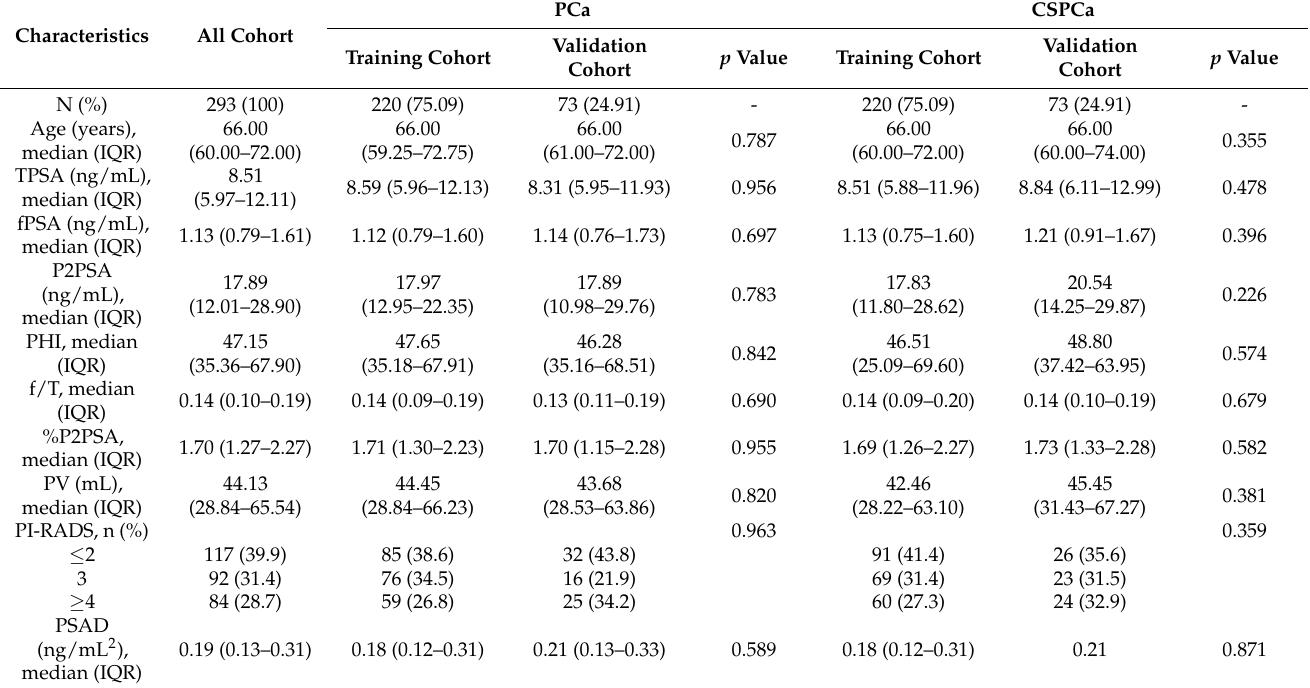
(Table 1). The characteristics of patients in the training and validation cohorts are shown in Tables 2 and 3. Table 1. Patients’ characteristics of the training cohort and validation cohort in total and significant prostate cancer.